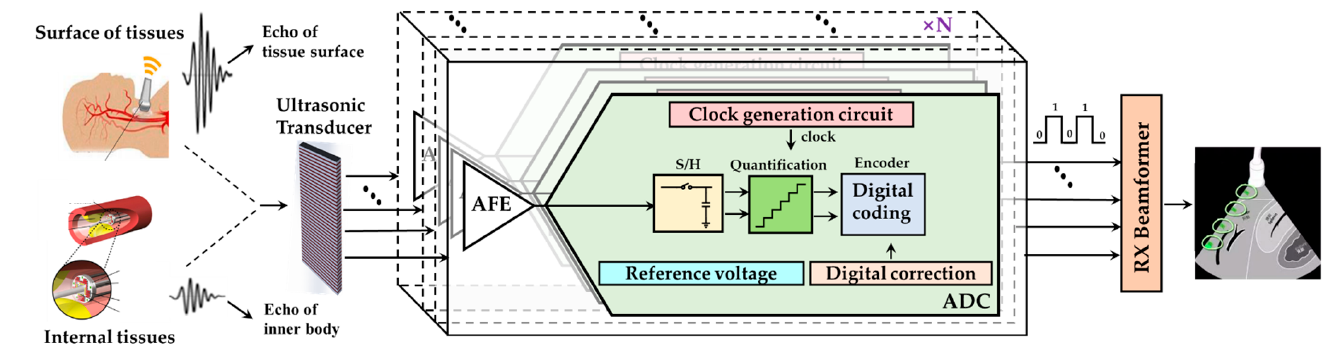
Figure 1. Schematic diagram of ultrasonic imaging receiver chain.